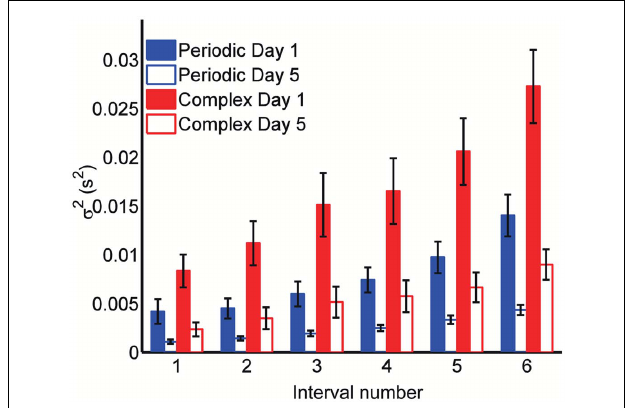
FIGURE 5 |Variance is smaller for periodic patterns. Mean variance at each response for the first and last days of training. Although both periodic and complex patterns had the same total duration (3s), the variance of the response times at the last response is smaller for the periodic pattern.